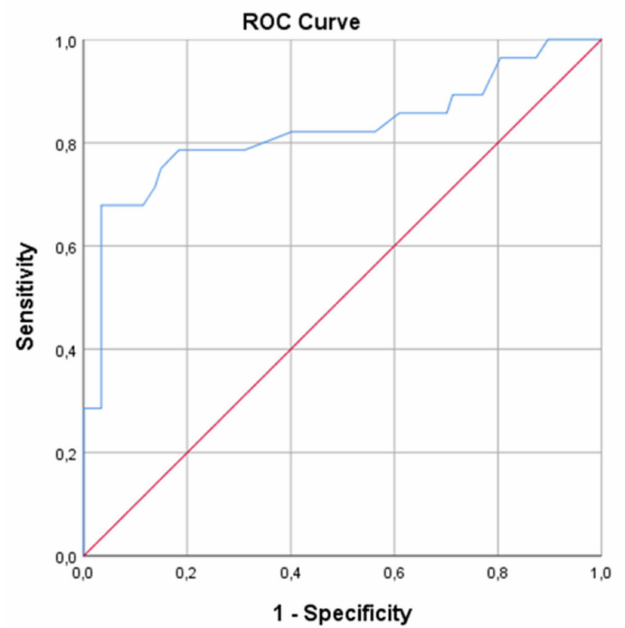
Figure 1. Receiver Operating Characteristics Analysis Curves for Serum Lateral Flow Assay for Diagnosing Proven/Probable Invasive aspergillosis or COVID-19 associated pulmonary aspergillosis vs. no aspergillosis in the overall Study